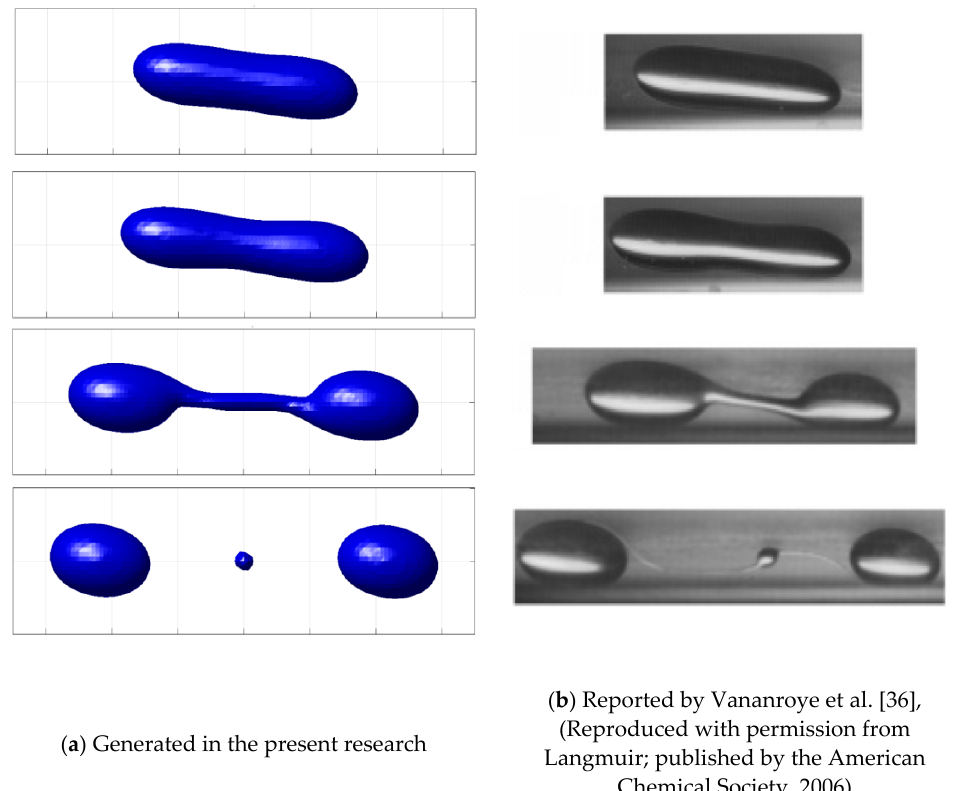
Figure 20. The different states of the deformation before the breakup of a drop with 2 R drop = 0.75 H , Ca = 0.6, and λ =